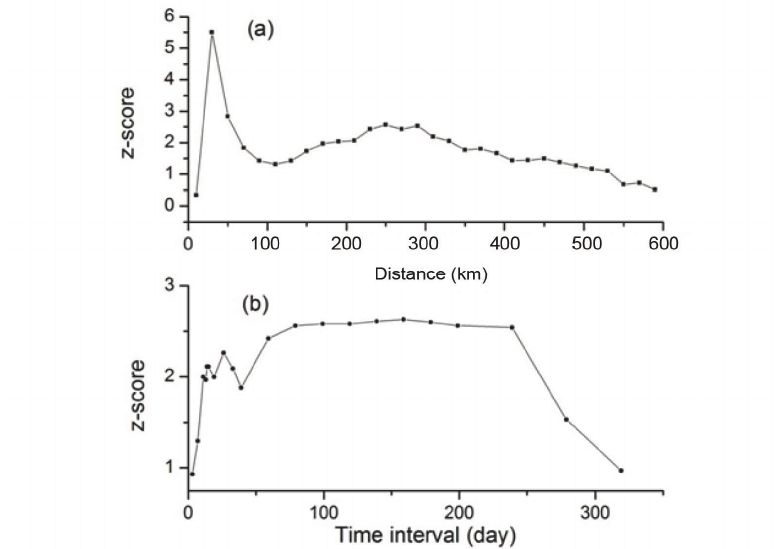
Figure 3. Results of Incremental Spatial Autocorrelation analysis ( a ) and Spatial Autocorrelation analysis ( b